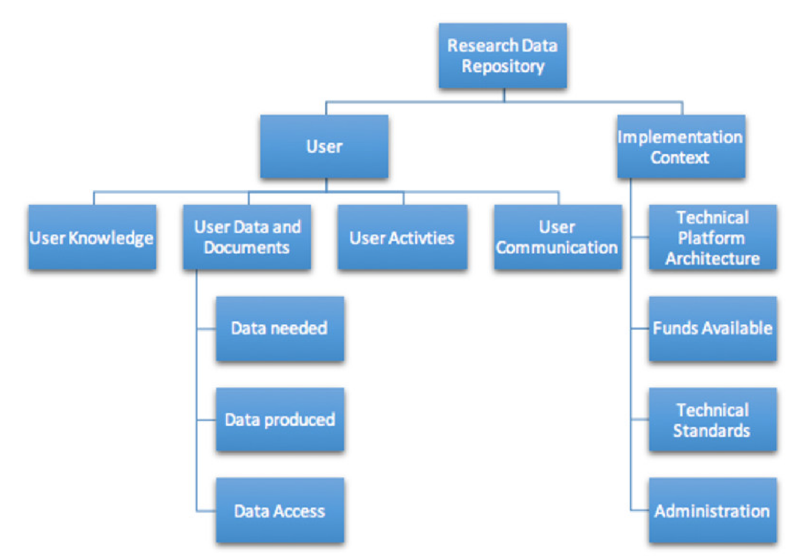
Figure 1. Important aspects that need to be considered for the creation of a geographic data repository for